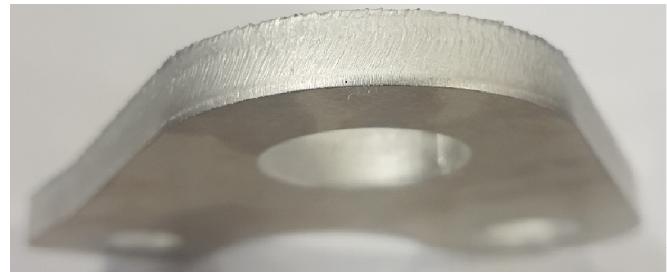
Figure A1. Edge surface quality of the cut 8 mm aluminum